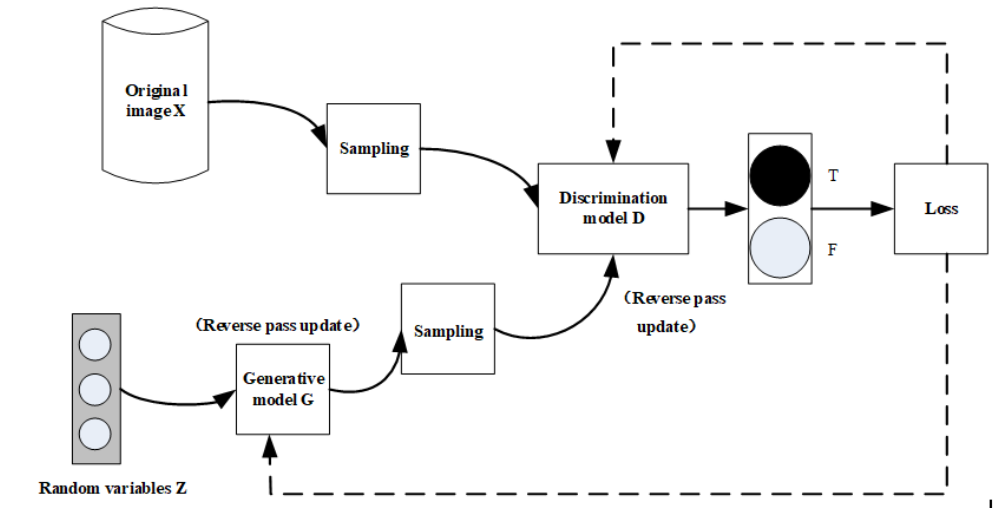
Fig. 2 GAN Network Structure